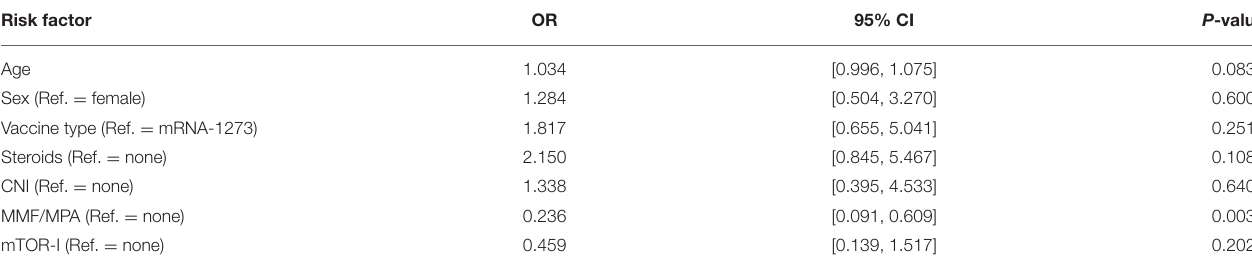
TABLE 2 | Multivariate analysis of IgG antibody decline between T2 and T3 in kidney transplant recipients after seroconversion [kidney transplant recipients (KTR) 112